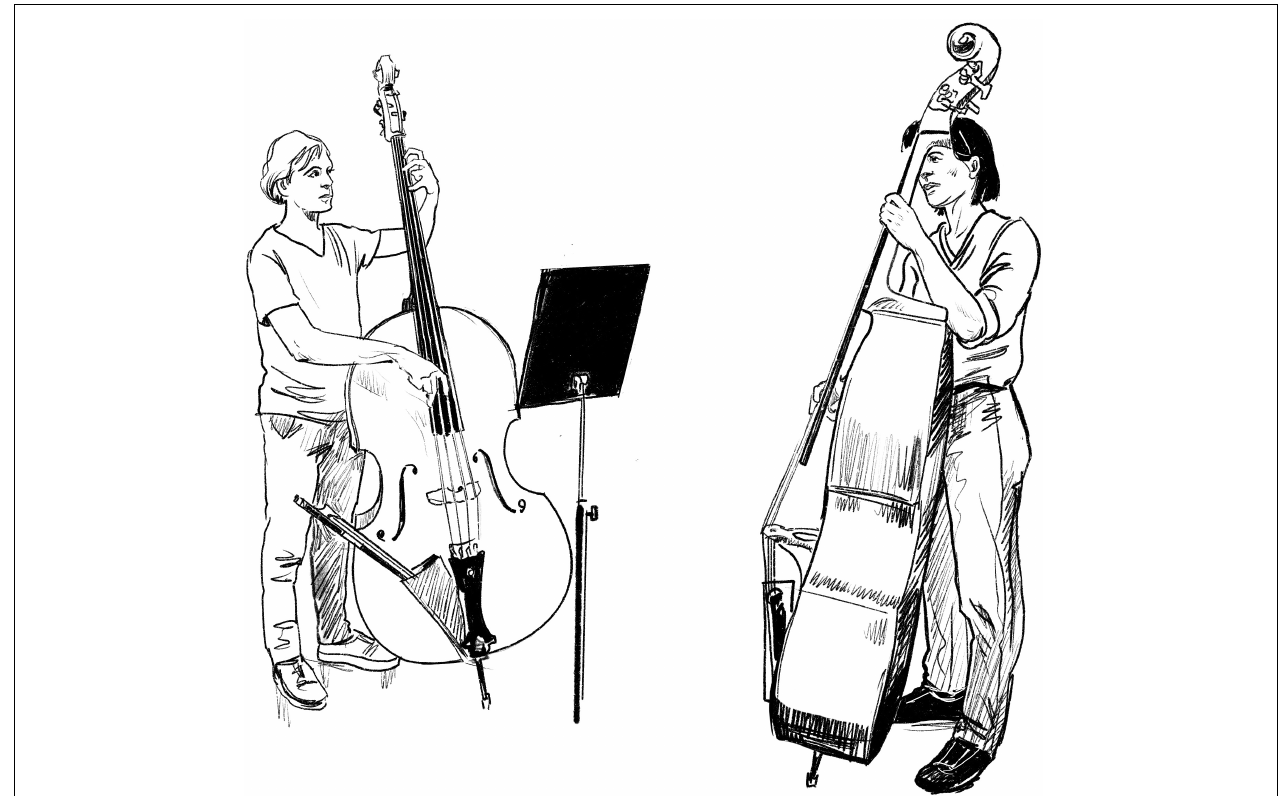
FIGURE 1 | Teacher and student